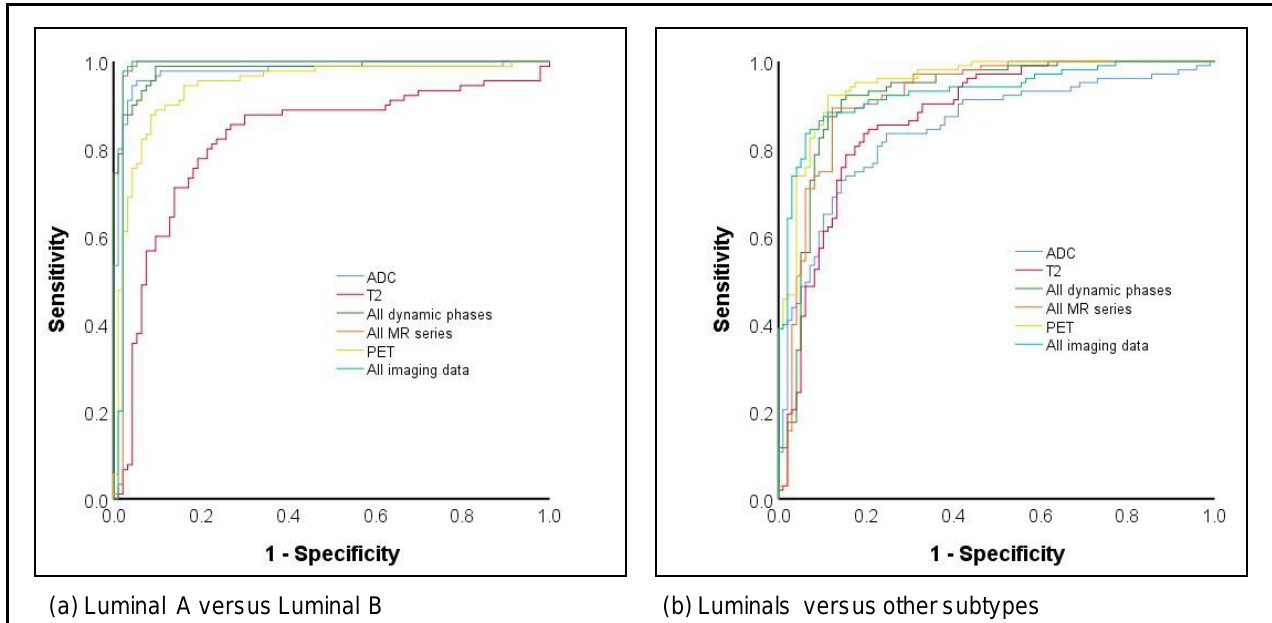
Figure 2. ROC curves for subtype prediction for ( a ) Luminal A versus Luminal B and ( b ) Luminals versus other subtypes.